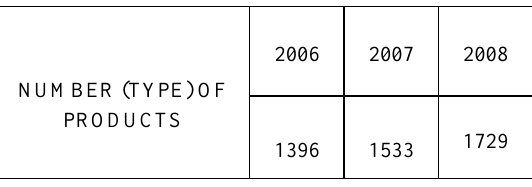
Table 1: Product Portfolio of XYZ over the